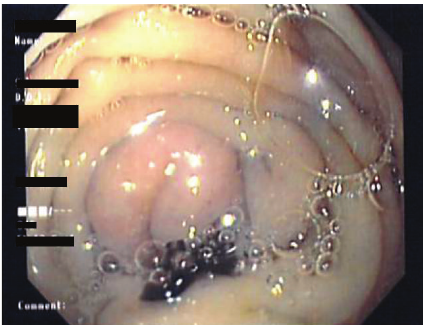
Figure 3: Bear Claw clip deployed at the enteric orifice of the fistula within the afferent limb.